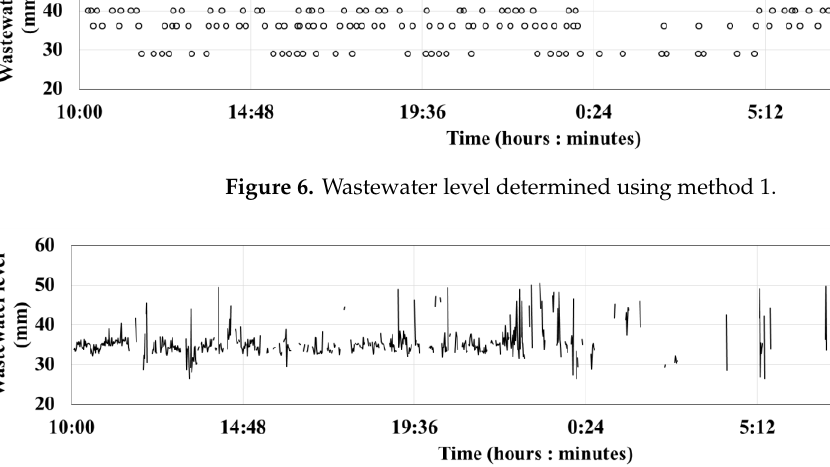
Figure 7. Wastewater level determined using method 2.